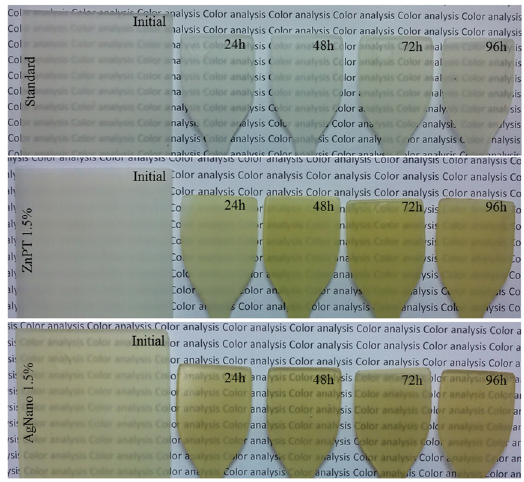
Figure 2. Color variation comparing Standard TPE samples and TPE incorporated with 1.5% of ZnPT and 1.5% AgNano, before and after 96 hours of UV light exposure.